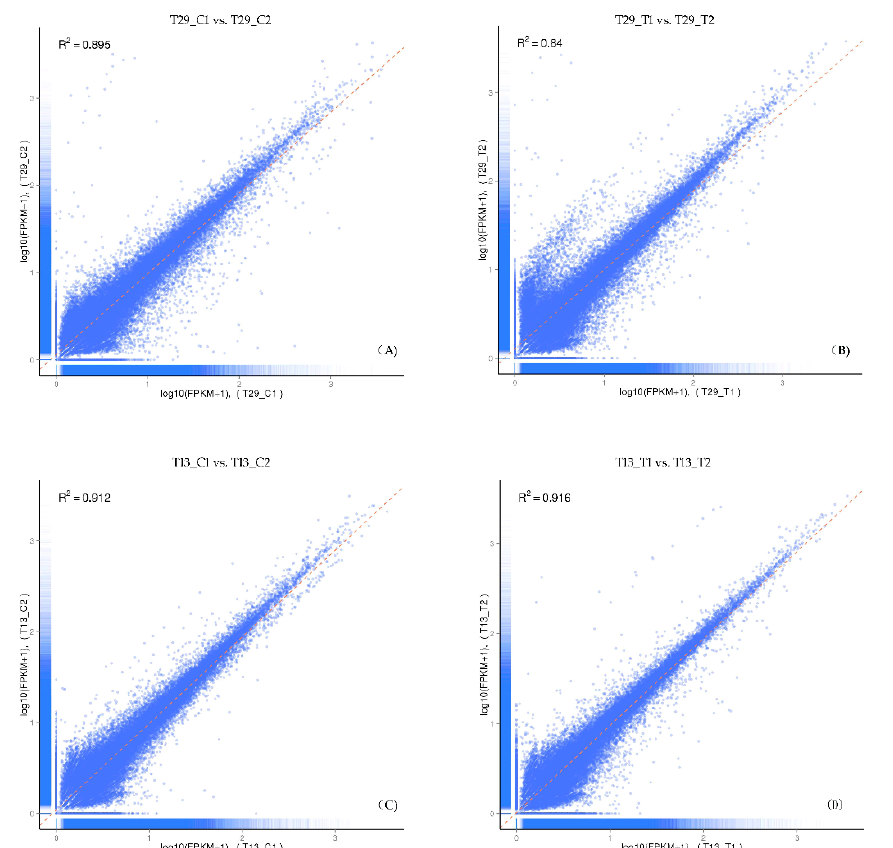
Figure 2. The correlation between the expression levels for each gene for the two biological replicates. Abscissa indicates log10(RPKM + 1) of Biological Replicate 1, Ordinate indicates log10(RPKM + 1) of Biological Replicate 2. T29 is the high-NUE genotype and T13 is the low-NUE genotype. Subfigures ( A ), ( B ), ( C ) and ( D ) show the correlation between the two biological replicates of T29_C (high-NUE genotype T29 under normal N treatment), T29_T (T29 under N-deficit treatment), T13_C (low-NUE genotype T13 under normal N treatment) and T13_T (T13 under N-deficit treatment), respectively.